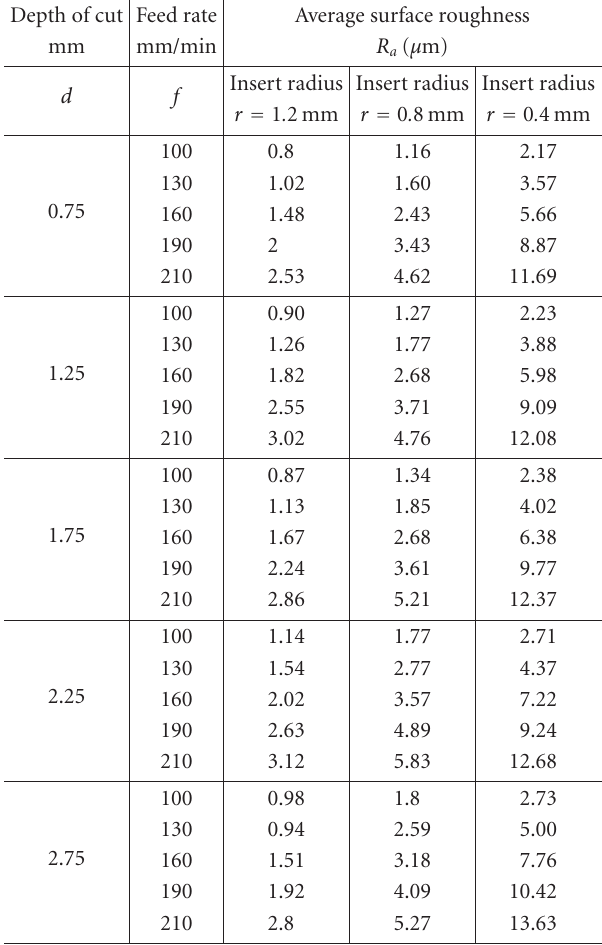
Table 4: The average surface roughness values depending on depth of cut, feed rate, and insert nose